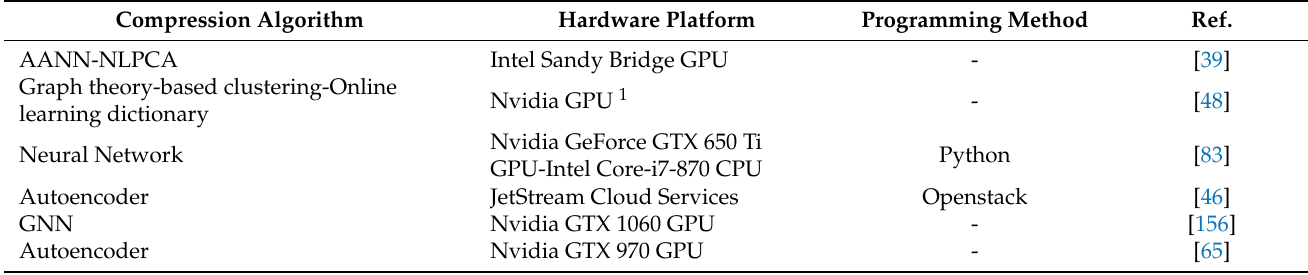
Table 9. List of studies on learning-based compression algorithms of hyperspectral images and their hardware